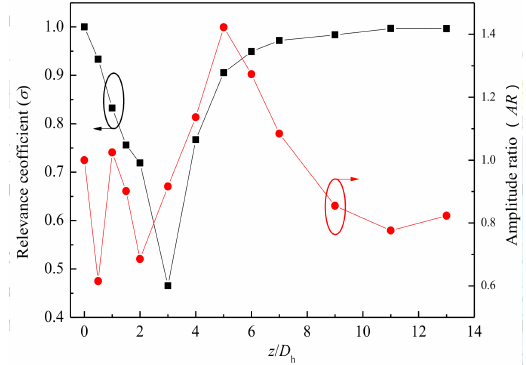
Figure 11. Relevance coefficients and amplitude ratios at R = 0.117 without